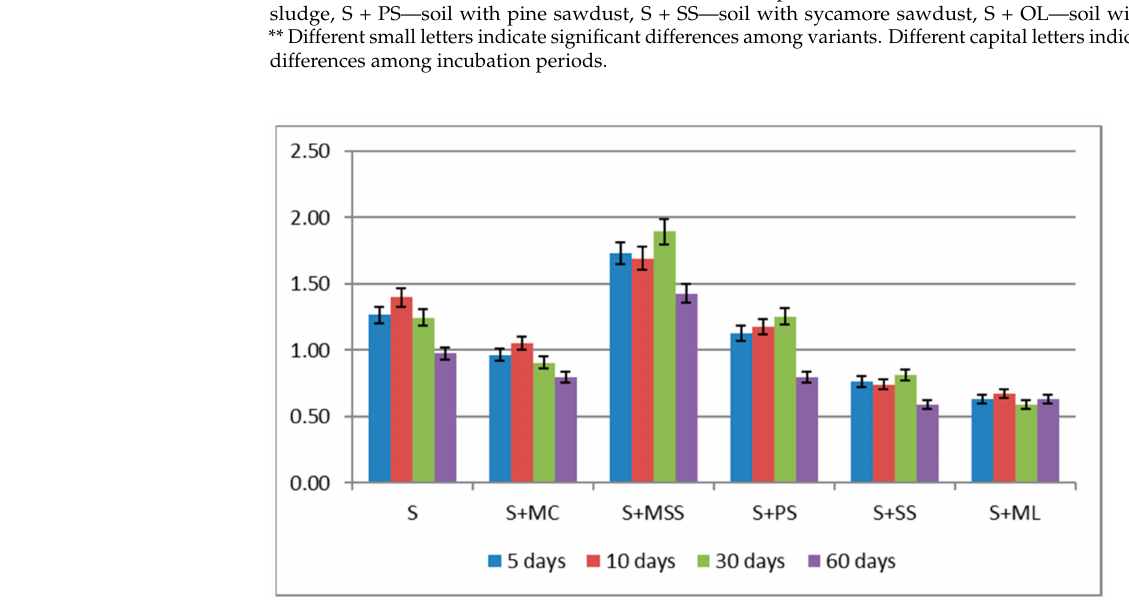
Figure 2. Soil quality indicator—the geometric mean G